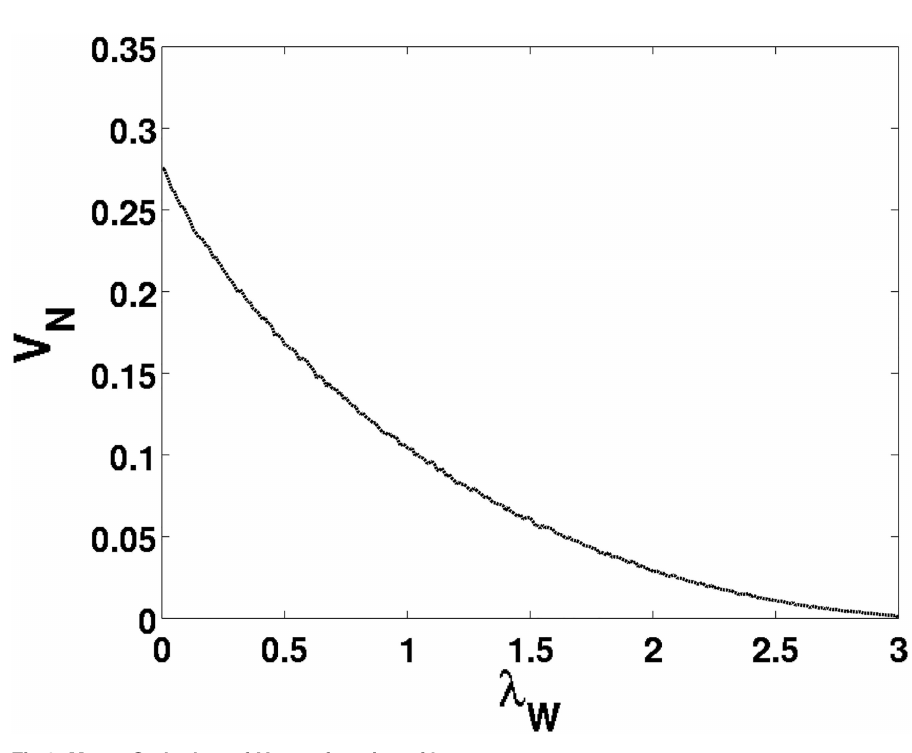
Fig 6. Monte Carlo data of V N as a function of λ W